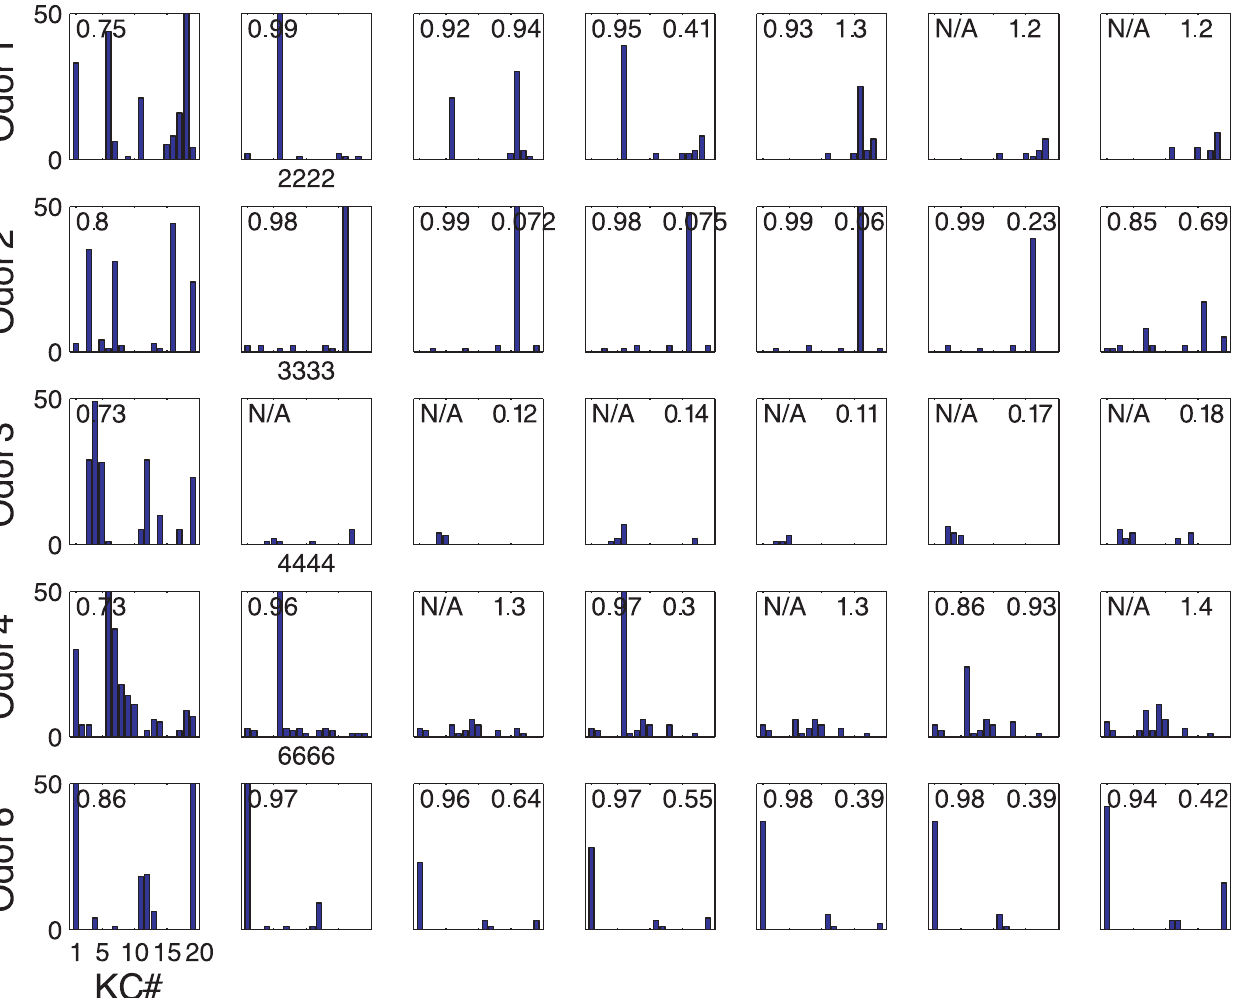
Figure 5. The persistence of olfactory representations. Columns: different response patterns of the KC population with respect to STDP-based plastic exposure to different arrangements of odors 1, 2, 3, and 4. From left to right: ‘‘naive’’; after learning on a test odor alone (e.g., ‘‘1111’’: four blocks of odor 1); after sequential learning on combinations of four different odor blocks (e.g., ‘‘2143’’: presentation of one block of each odor, i.e., odor 2, followed by odor 1, odor 4 and odor 3); ‘‘RANDOM’’, after learning on a sequence of randomly permuted single 1-s trials of the odors 1, 2, 3, and 4. Rows: the olfactory circuits above were tested by presenting one block of a single odor in the learning sequence. Last row: the same olfactory circuits were additionally tested with the presentation of one block of an odor (odor 6) that was not included in the learning sequence. The sparseness measure Sp for each condition is indicated in the upper left corner of the spike count bar plots (N/A: not available, less than 1/4 of 1-s trials elicited on average at least one spike). For each multiple odor sequence, the Euclidean distance in 19-D KC odor space from the average representation after learning on a test odor alone is indicated in the upper right corner.